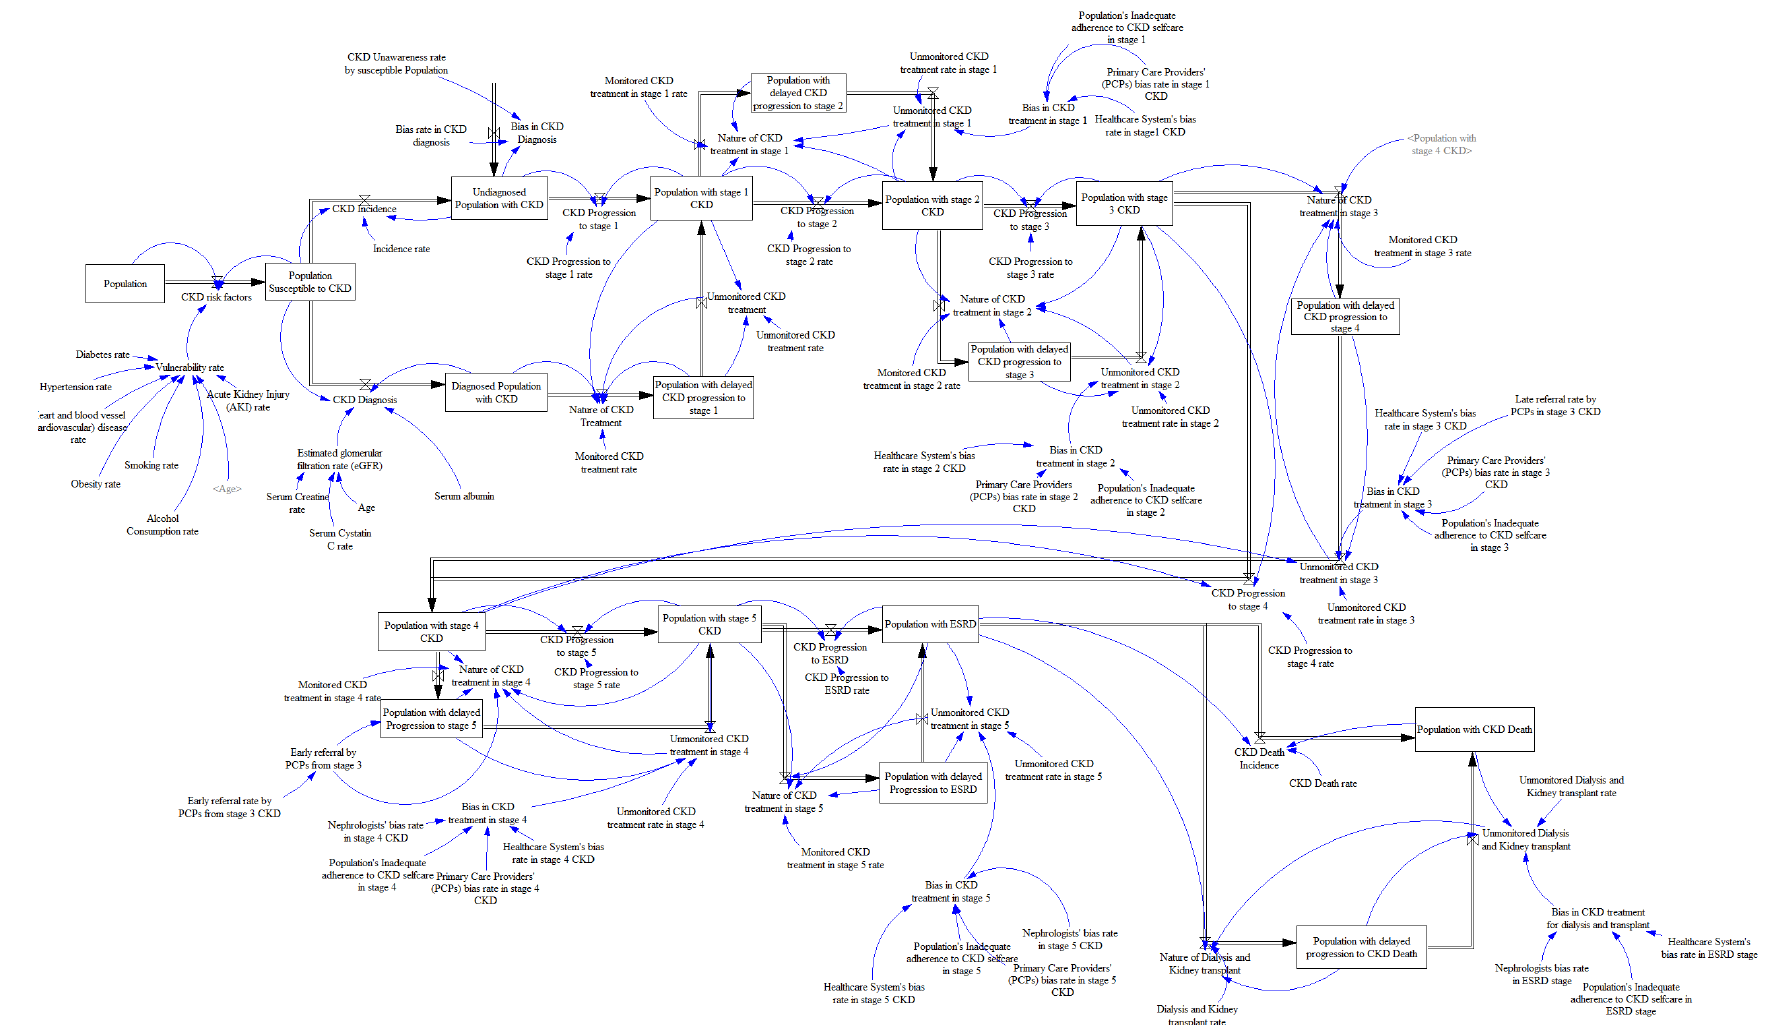
Figure 2. System Dynamics Modeling Representing CKD Incidence, Prevalence, and Health